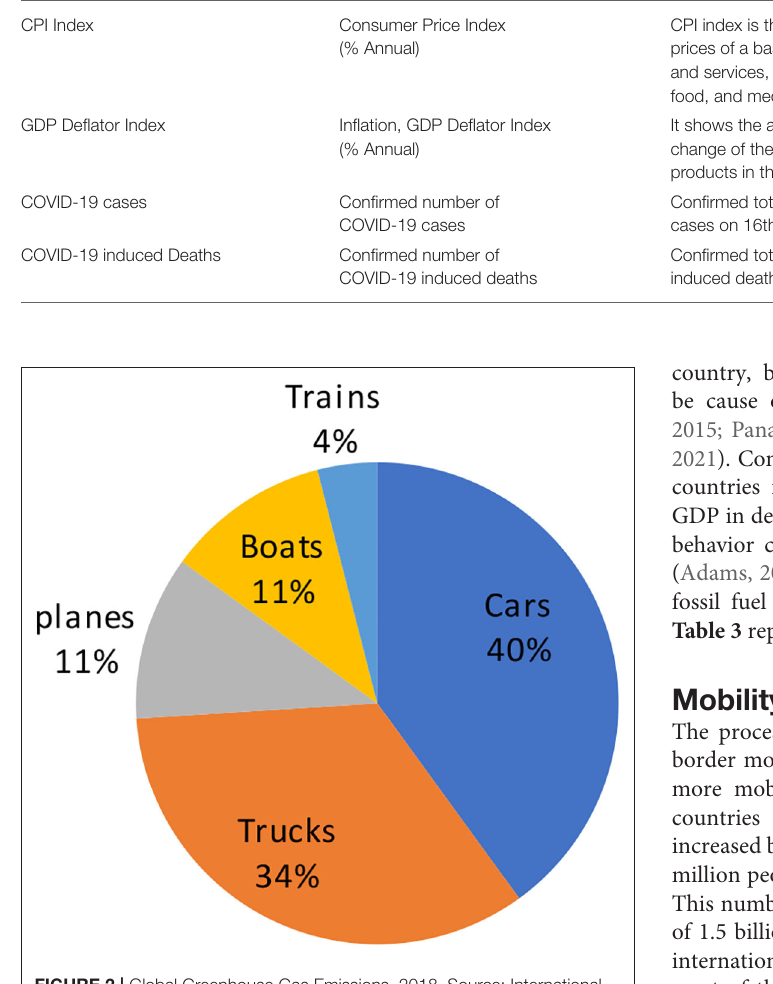
FIGURE 2 | Global Greenhouse Gas Emissions, 2018. Source: International Council on Clean